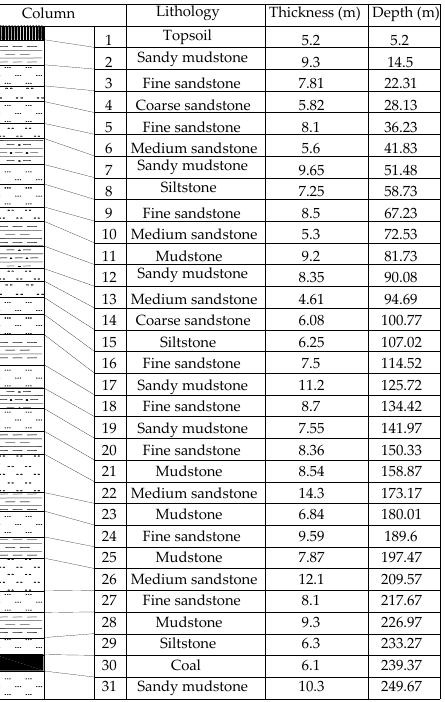
Figure 6. The stratigraphic column of the panel 5304.